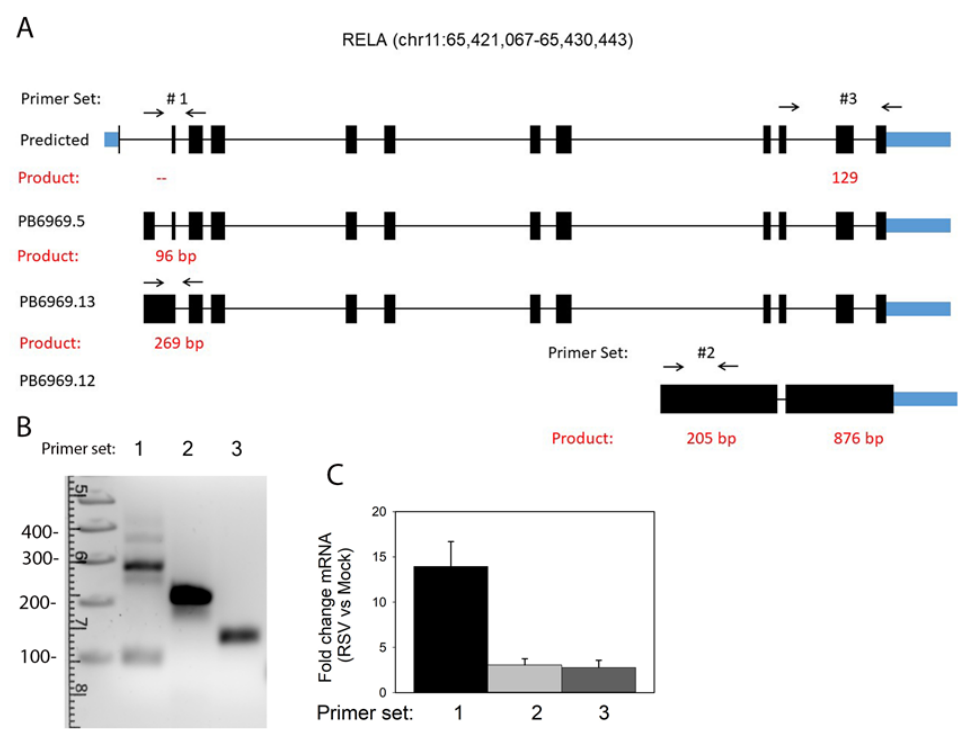
Figure 10. Validation of RelA alternative mRNA processing. ( A ) Primer sets #1-#3 were designed to validate differential exon inclusion/exclusion. The expected size of the PCR product is indicated in red and tabulated in Table II. ( B ) Quantitative PCR for each primer set. hSAECs were infected with RSV and RNA analyzed for isoform expression. Shown is 2% agarose gel electrophoresis stained with GelRed dye (Biotium), with molecular weight (MW, in nt) indicated at the left. Fragments were isolated and sequenced to confirm splice site selection. ( C ) Quantitation of RelA isoforms expressed as a fold change in RSV-infected over uninfected cells (mock).